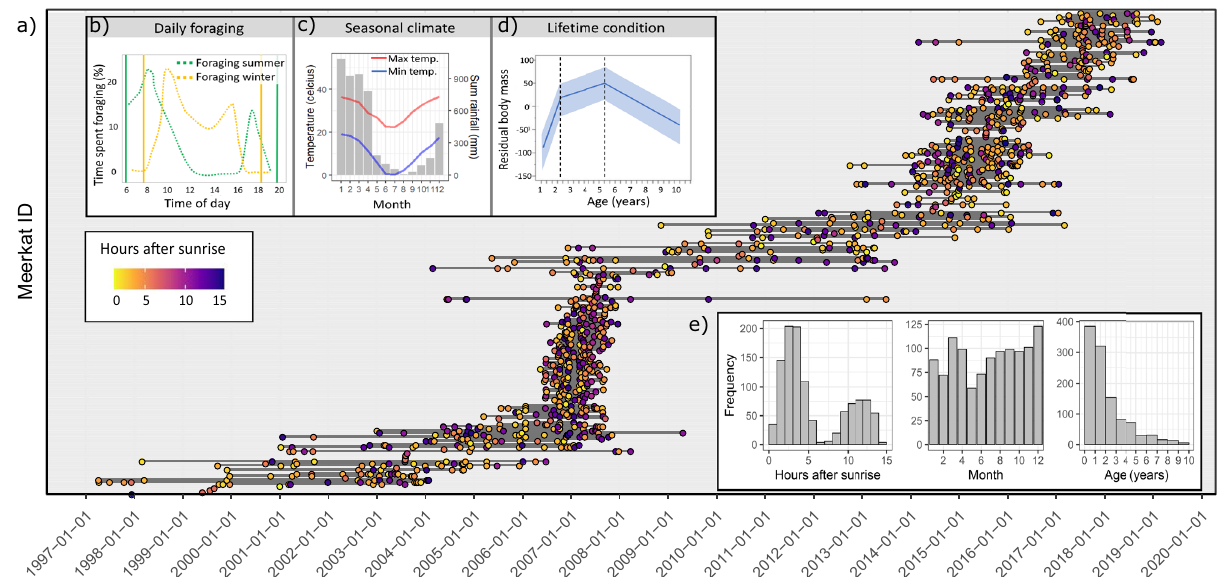
Fig. 1 Study system and sampling distribution. a Timeline of samples analysed in this study (1997 – 2019; n = 1109), with lines connecting samples collected from the same meerkat individual ( y -axis), and coloured by hours after sunrise. Yellow represents samples collected close to sunrise, purple represents samples collected closer to sunset. Periods of intensive sampling (~2007 and 2015) enable us to account for environmental and social effects at certain periods. b Proportion of time meerkats spend foraging during wet summer (green dashed line) and dry winter (yellow dashed line). Figure modi fi ed from Doolan and MacDonald 28 with permission. Solid lines represent sunrise and sunset in summer (green) and winter (yellow). c Seasonal climate across the year measured at the Kalahari Research Station, South Africa, averaged from data between 2009 and 2019. Bars represent total rainfall per month, and red and blue lines represent mean maximum and minimum temperatures, respectively. d Trend in residual body mass across life showing senescence at approximately 5.5 years and 95% credible intervals, modi fi ed from Thorley et al. 29 . e Sampling distribution for diurnal, seasonal, and lifetime scales. Source data are provided in the source data fi